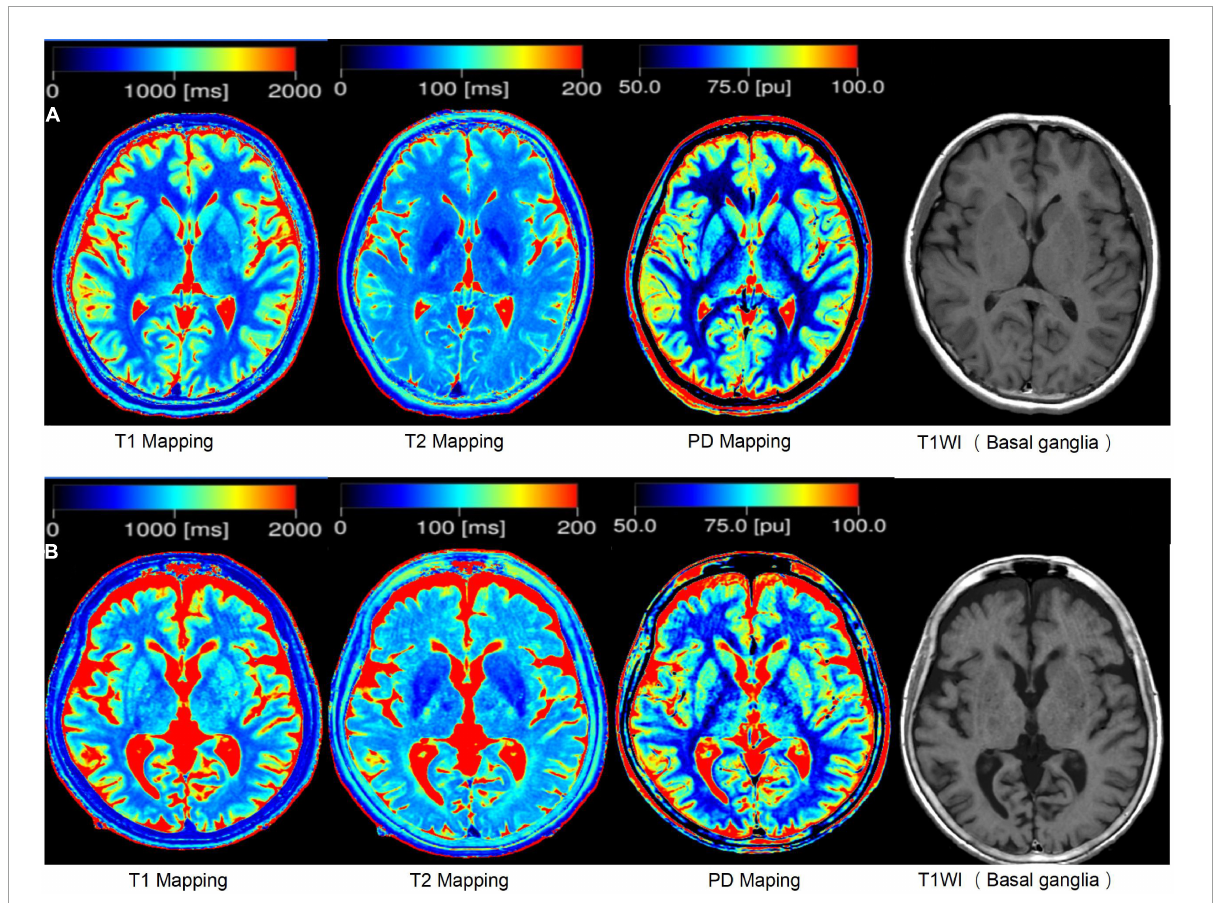
FIGURE1 The example of syMRI. (A) Shows the brain of a 25-year-old person, and (B) shows the brain of a 83-year-old person.